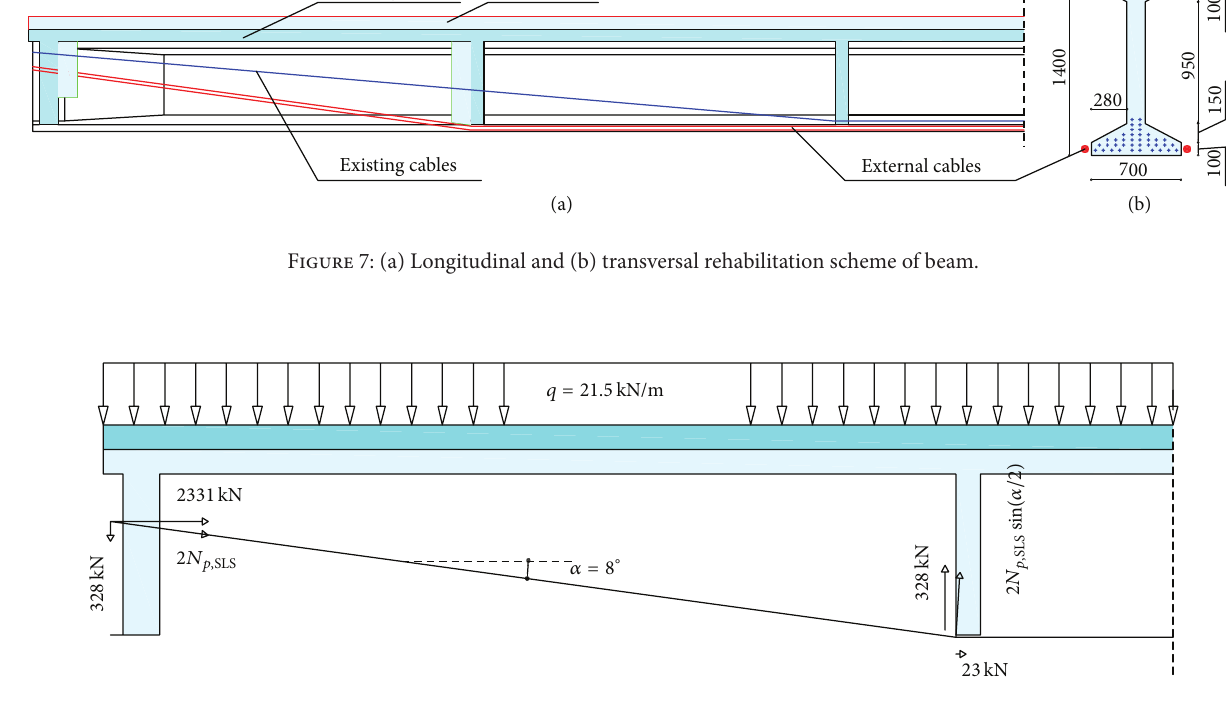
The shear reinforcement was variable along the